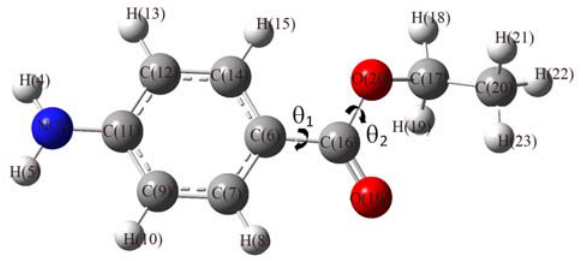
Fig. 1. Benzocaine molecule with selected flexible torsion